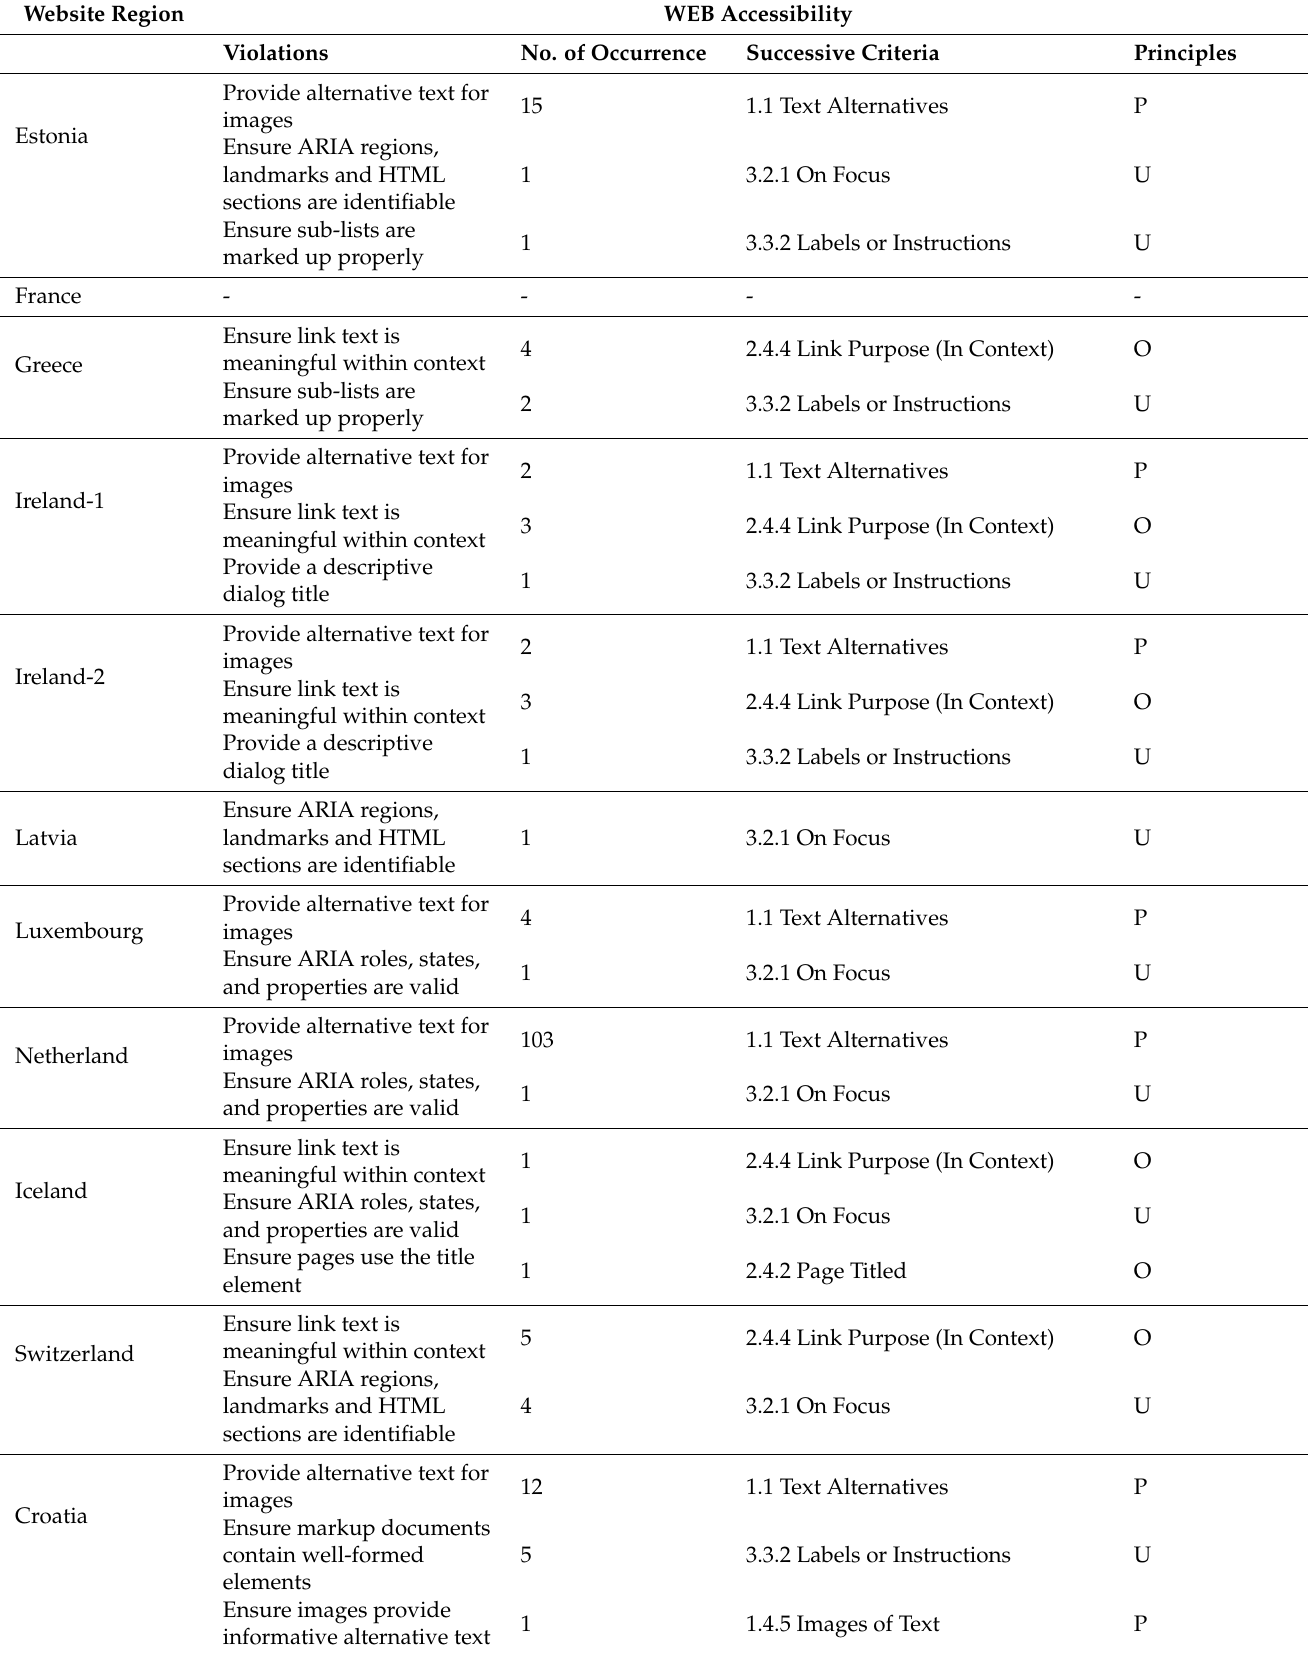
Table A5. Accessibility issues in the website of each country by WEB